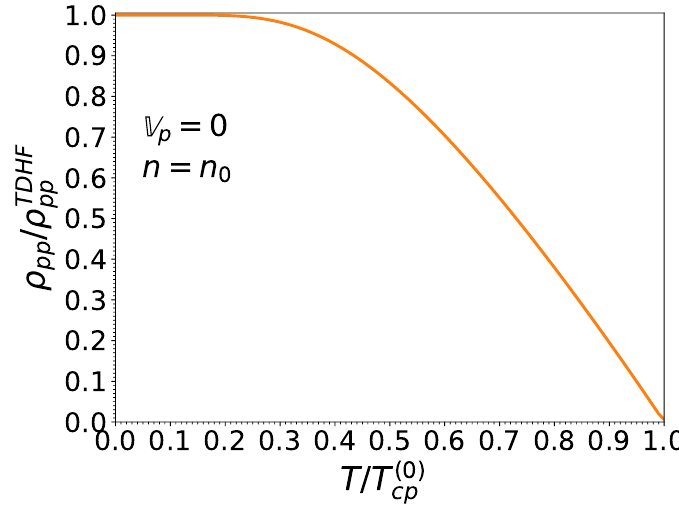
Figure 16. Same as Figure 13 at the saturation density n 0